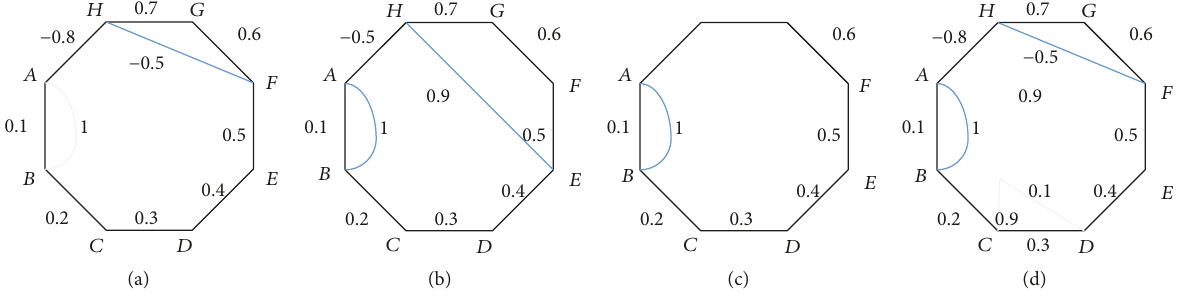
Figure 4: Network topology